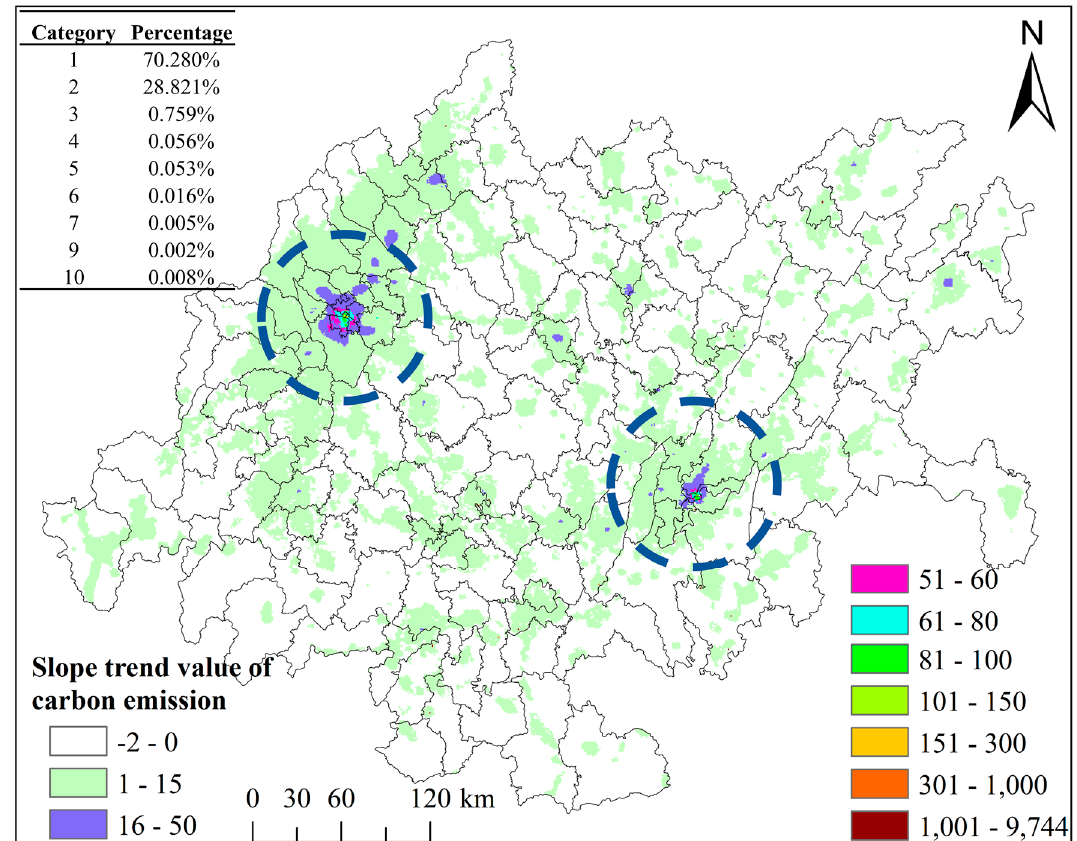
Figure 7. Slope trend distribution of carbon emissions from 2000 to